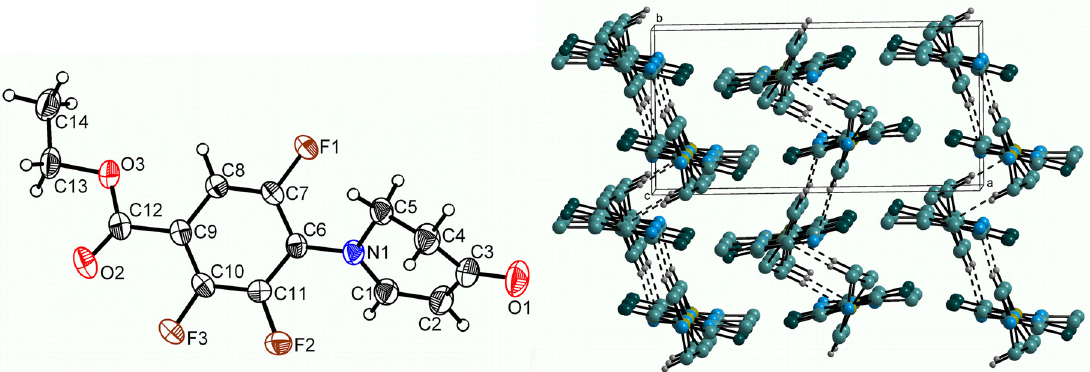
Table  : Data collection and